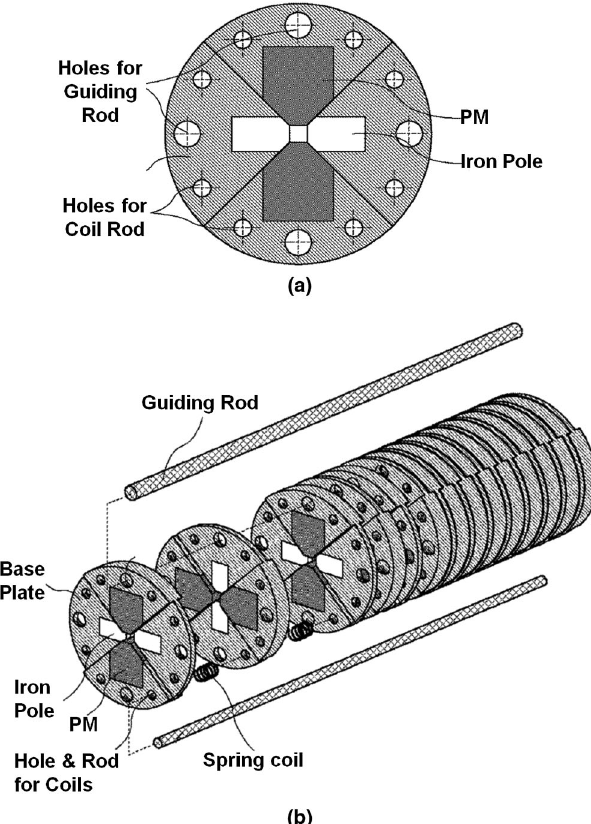
undulator.FIG. 3. (a) Schematics of a basic module of the V-P helical permanent-magnet undulator. The module contains two perma- nent magnets and two iron poles. (b) Assembly configuration of the